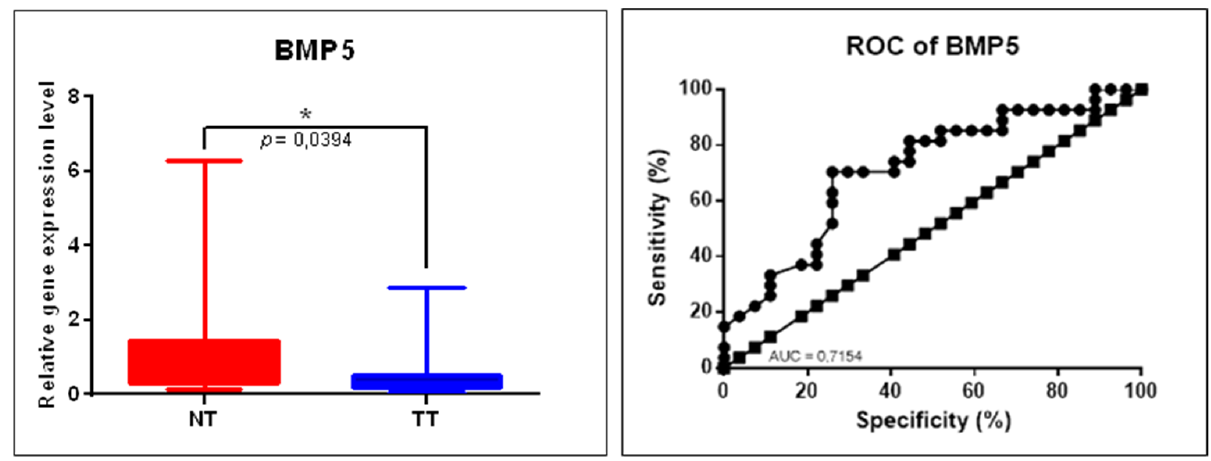
Figure 8. BMP5 gene expression alteration in COAD evaluated by qRT-PCR. Scatter plots demonstrate the downregulation of BMP5 in tumor tissues (TT, n = 29) versus normal tissues (TN, n = 29), B2M was used as a housekeeping gene (* p ≤ 0.05); ROC curves for each selected gene’s specificity and sensitivity (NT: normal tissue, TT: tumoral tissue, ROC: receiver-operating characteristic, AUC: area under ROC curve).